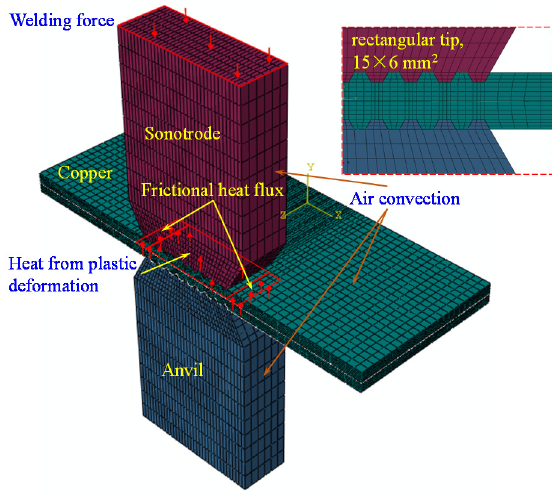
Figure 4. Finite element model of Cu-ETP ultrasonic welding. Table 3. Physical property parameters of the sonotrode and anvil.